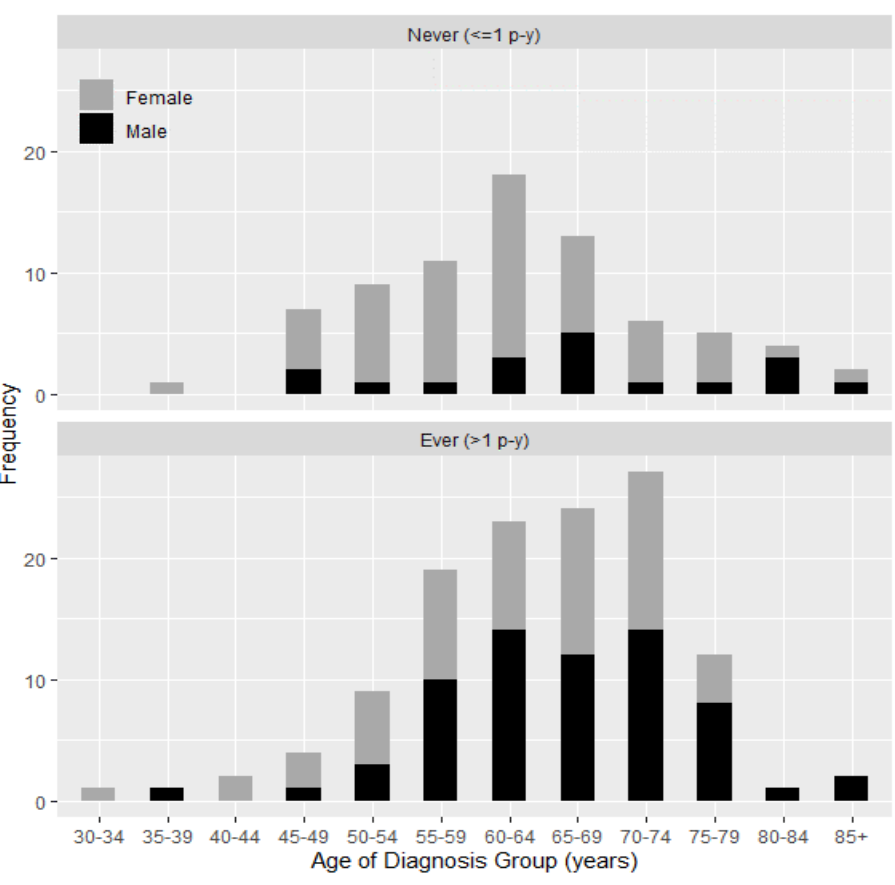
Figure 1. Distribution of age of lung cancer diagnosis in women and men by smoking